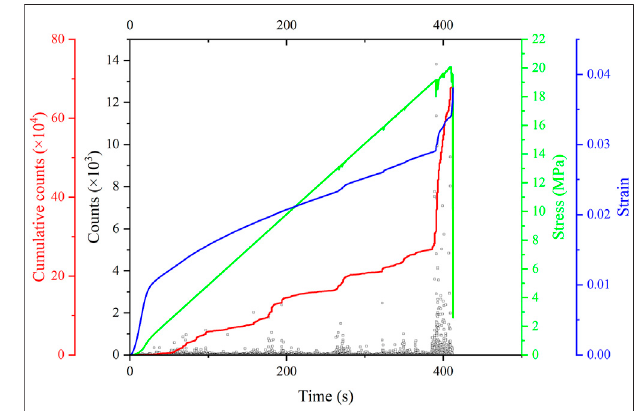
FIGURE5| Therelationshipbetween thesamplestress,strain, acoustic emission count, and acoustic emission cumulative count with uniaxial